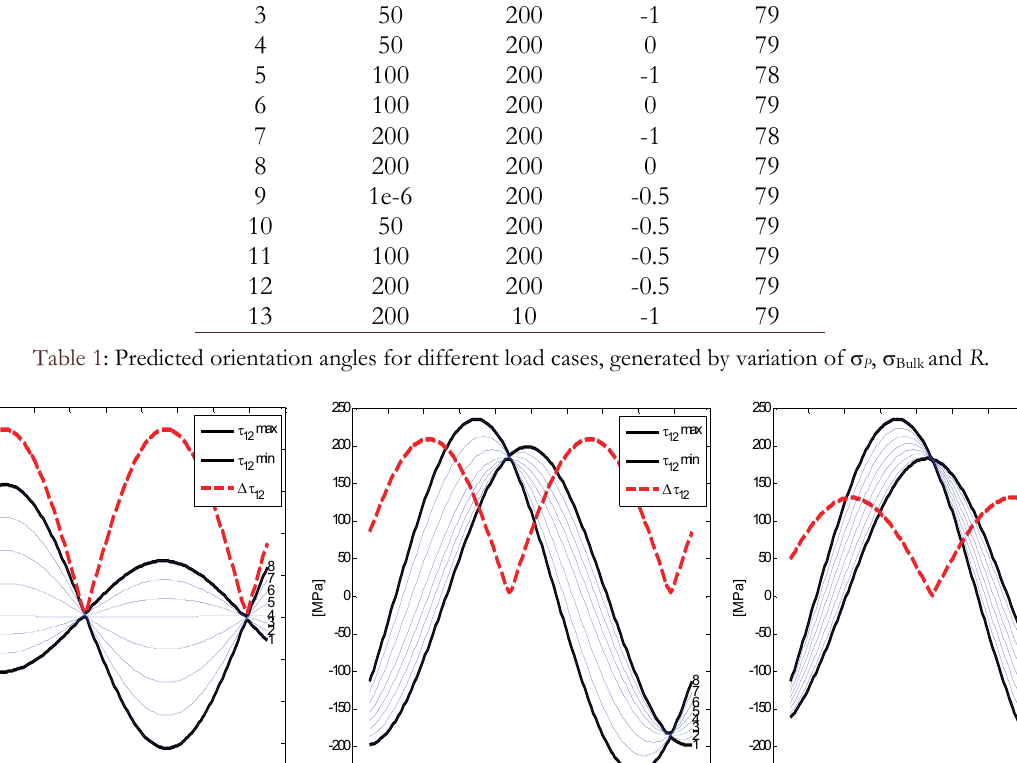
-100 -80 -60 -40 -20 Figure 7: Application of the min(  ) criterion for cases 1, 7 and 8, leading to predicted angles of 79º, 78º and 79º,